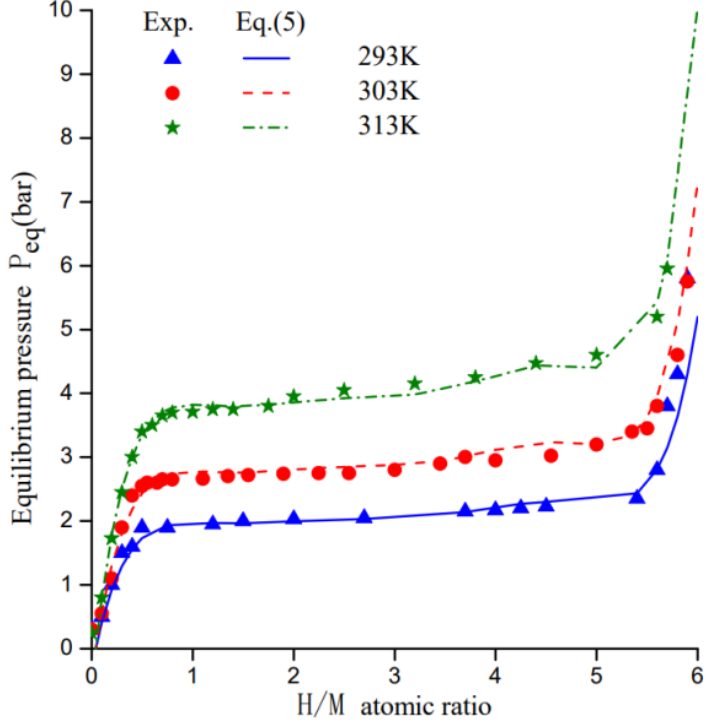
Figure 1. Equilibrium pressure for the hydrogen absorption reaction.